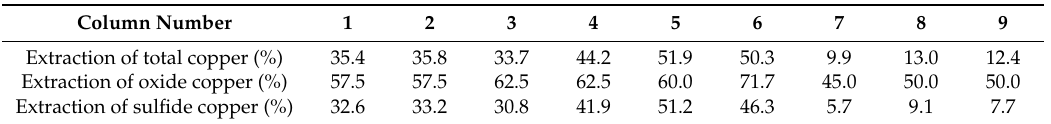
Table 8. Percentage of copper extraction from oxides and sulfides. Column Number